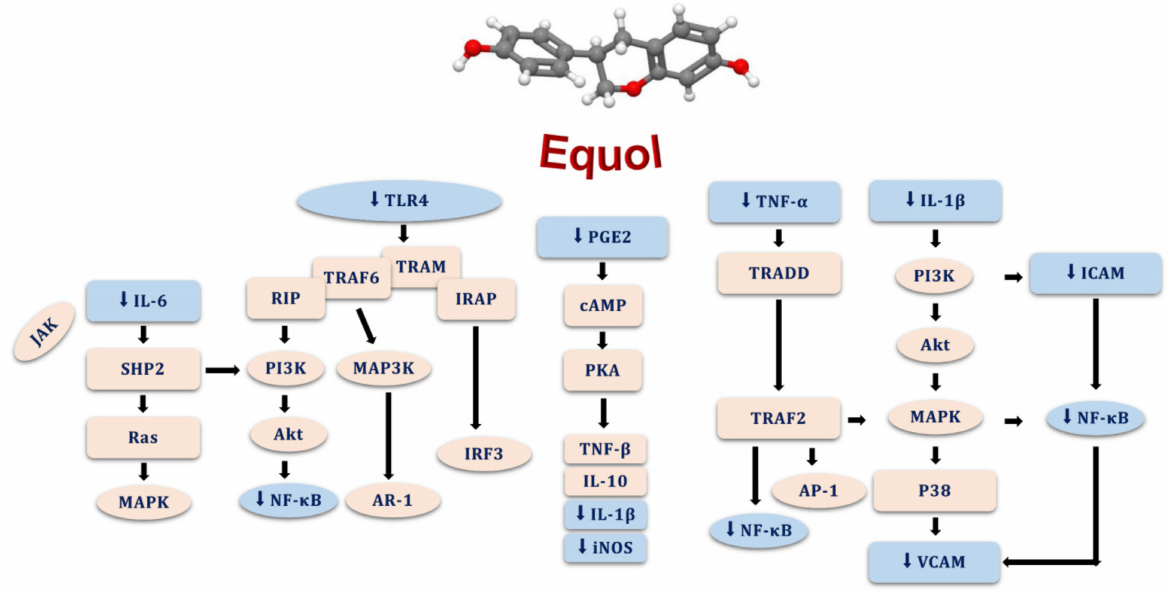
Figure 5. Anti-inflammatory activity mechanisms of equol. Akt: protein kinase B, AP: activator pro- tein, AR: androgen receptor, cAMP: cyclic adenosine monophosphate, ICAM: intercellular adhesion molecule, IL: interleukin, IRAP: insulin-responsive aminopeptidase, IRF: IFN regulatory factor, iNOS: nitric oxide system, JAK: janus kinase, MAPK or P38: mitogen-activated protein kinase, NF- κ B: nu- clear factor kappa B, PGE2: prostaglandin E2, PI3K: phosphoinositide 3-kinase, PKA: protein kinase A, SHP: Src homology-2 domain-containing protein tyrosine phosphatase, TLR: Toll-like receptor, TNF: tumor necrosis factor, TRADD: TNFR1-associated death domain protein, TRAF: TNFR-associated factor, TRAM: TRIF-related adaptor molecule, VCAM: vascular cell adhesion